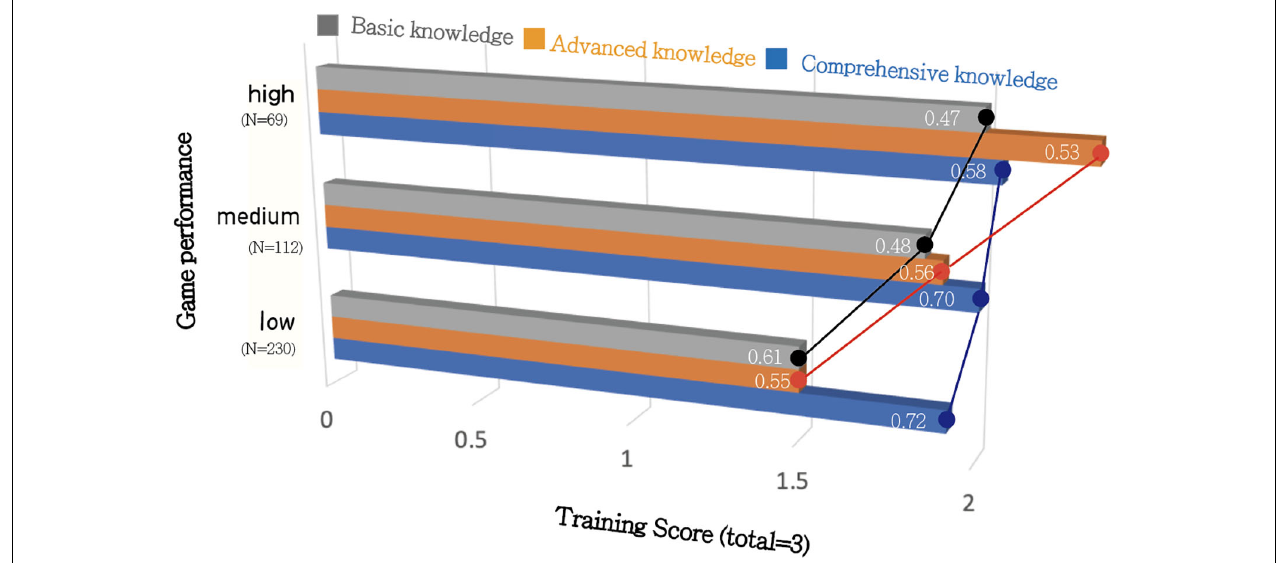
FIGURE 7 | The relationship between training score and EGCnrt game performance. The number of students belonging to groups of low, medium, and high performance in EGCnrt is 230, 112, 69, respectively. In the total number of 425 samples, 14 went missing due to incorrect coordination. The number within each horizontal bar represent the coefficient of variation (the ratio of standard deviation to the